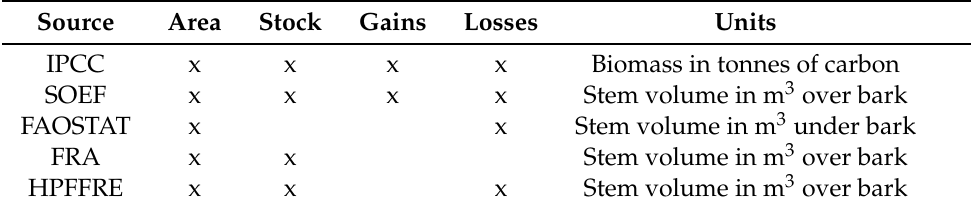
Table 1. Overview of the variables of interest in each